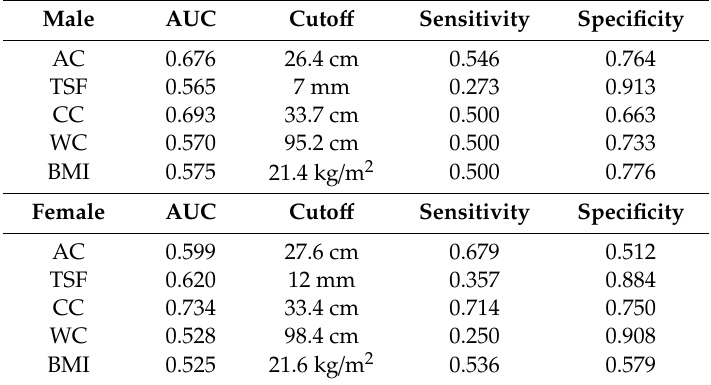
Table 4. ROC analysis for the presence of frailty in male and female participants.